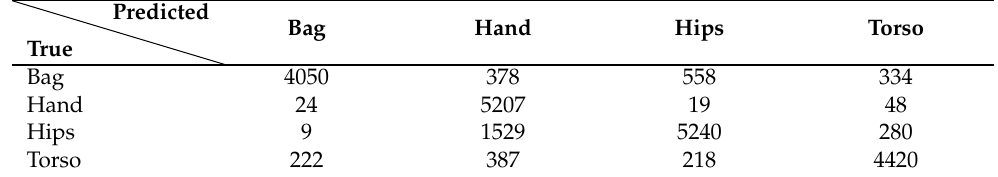
Table 3. Location detection confusion matrix.